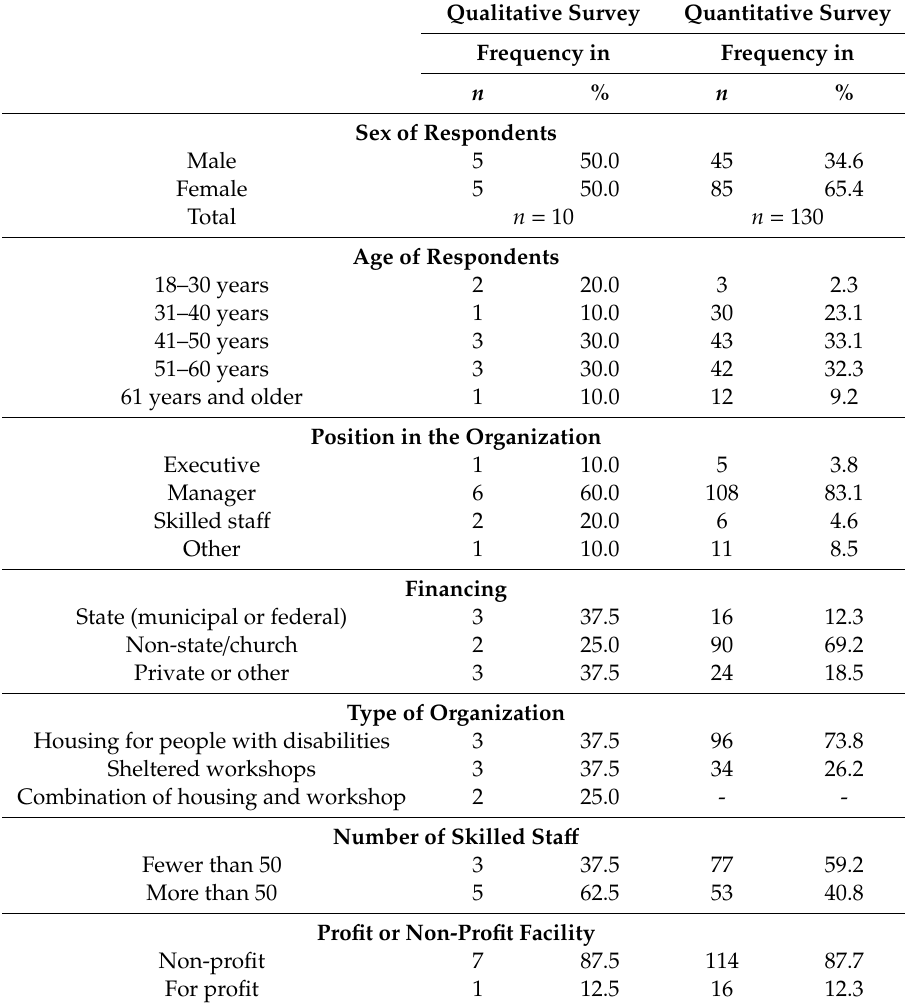
Table 1. Sample description of the quantitative and qualitative